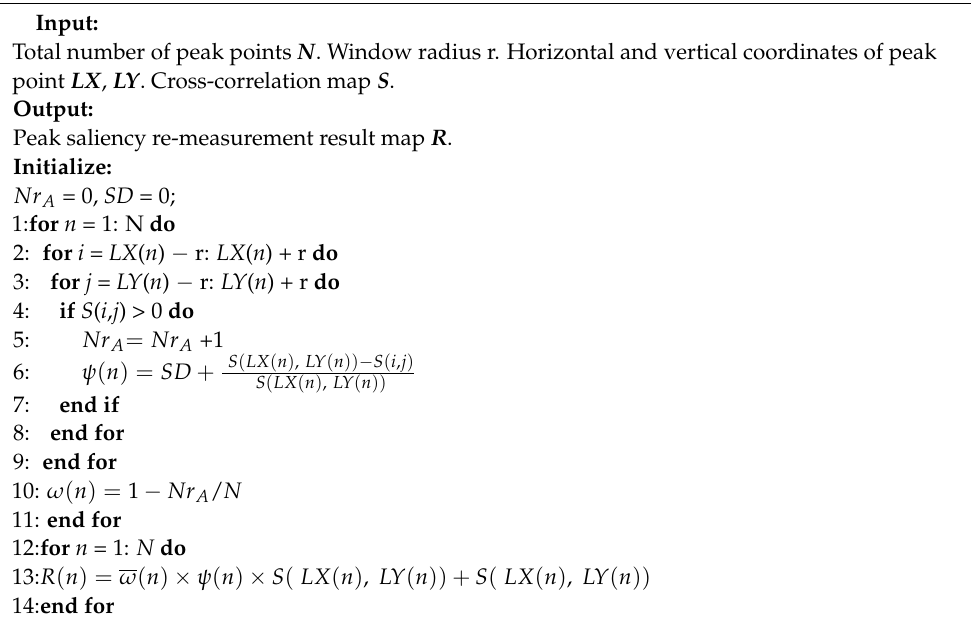
Algorithm 3: Peak saliency re-measurement and binary segmentation